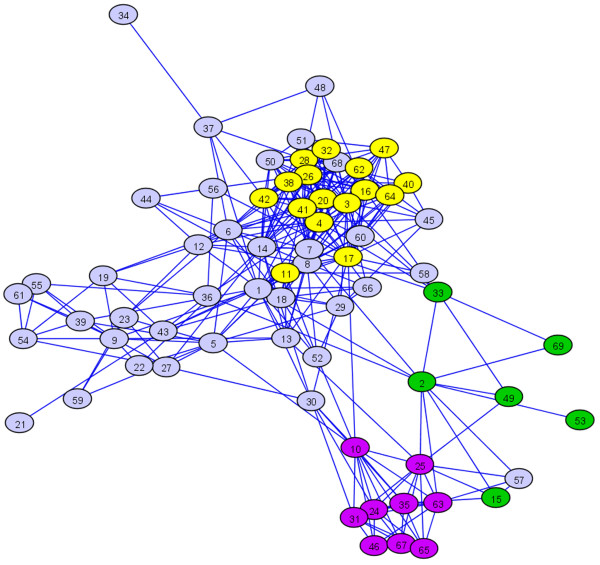
Higher-order structure in the coexpression network. All regulons containing at least 20 genes are depicted; these comprise a total of 9,436 genes. Regulons are represented by ovals numbered 1 through 69. A linkage between two clusters means that one or more genes in one of the clusters are correlated with one or more genes in the other cluster. As observed from the proximity of regulons with similar broader functional category, three super-clusters of regulons are revealed: regulons related to information-related functions (purple), plastidic functions (green) and defense response-related functions (yellow). The predominant functionality of each regulon is defined in Table 1. Network was visualized using the GraphExplore tool [118].